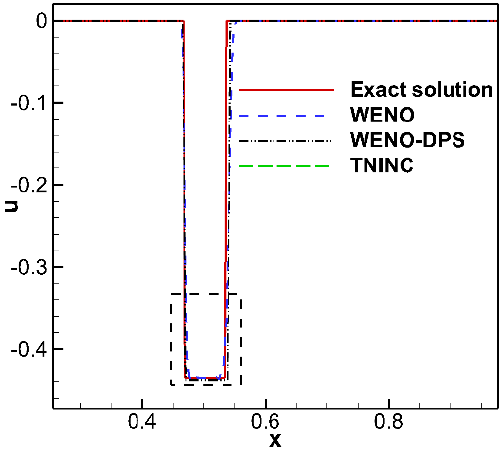
Figure 7. Density plot of RELS test case with Figure 8. Zoomed view of density plot of RELS